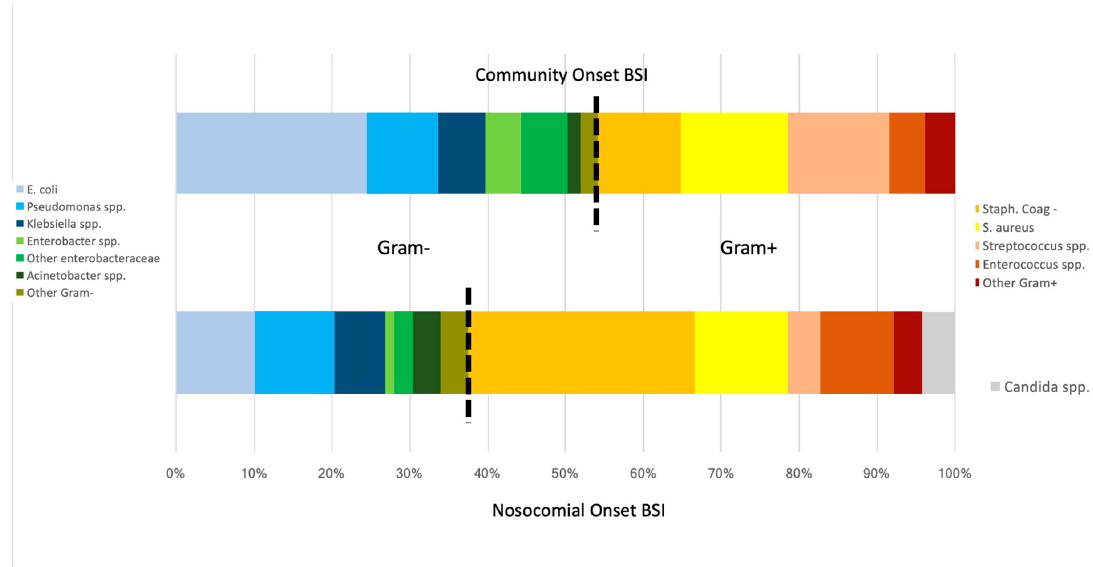
Figure 1. Microbiological distribution of bloodstream infection (BSI) isolates in the whole hospital according to Gram stain and origin of BSI (nosocomial or hospital acquired).